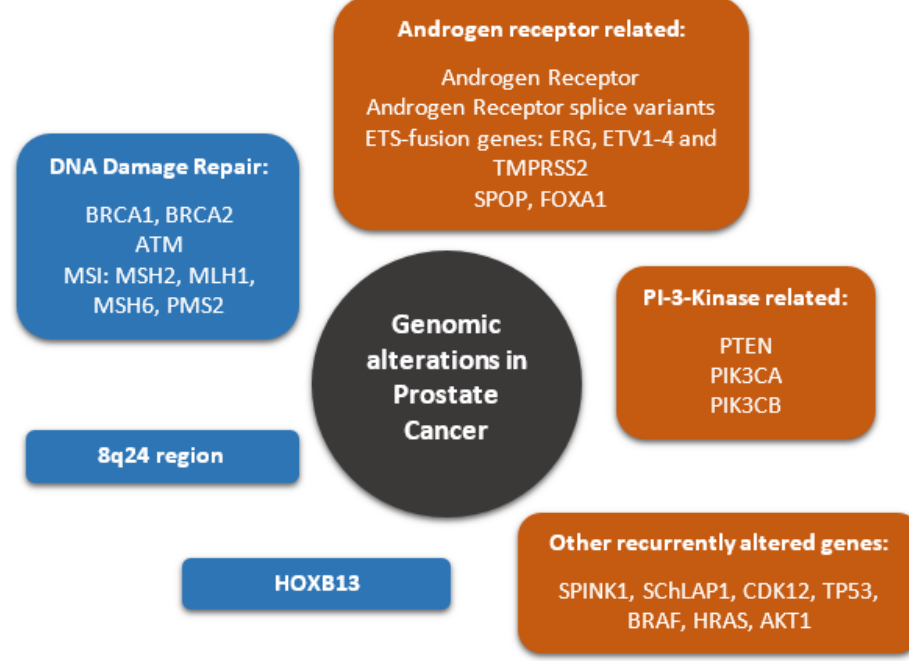
Figure 1. Common genomic alterations in prostate cancer. Germline mutations are highlighted in blue, while typical somatic mutations are highlighted in orange. For abbreviations see full text.